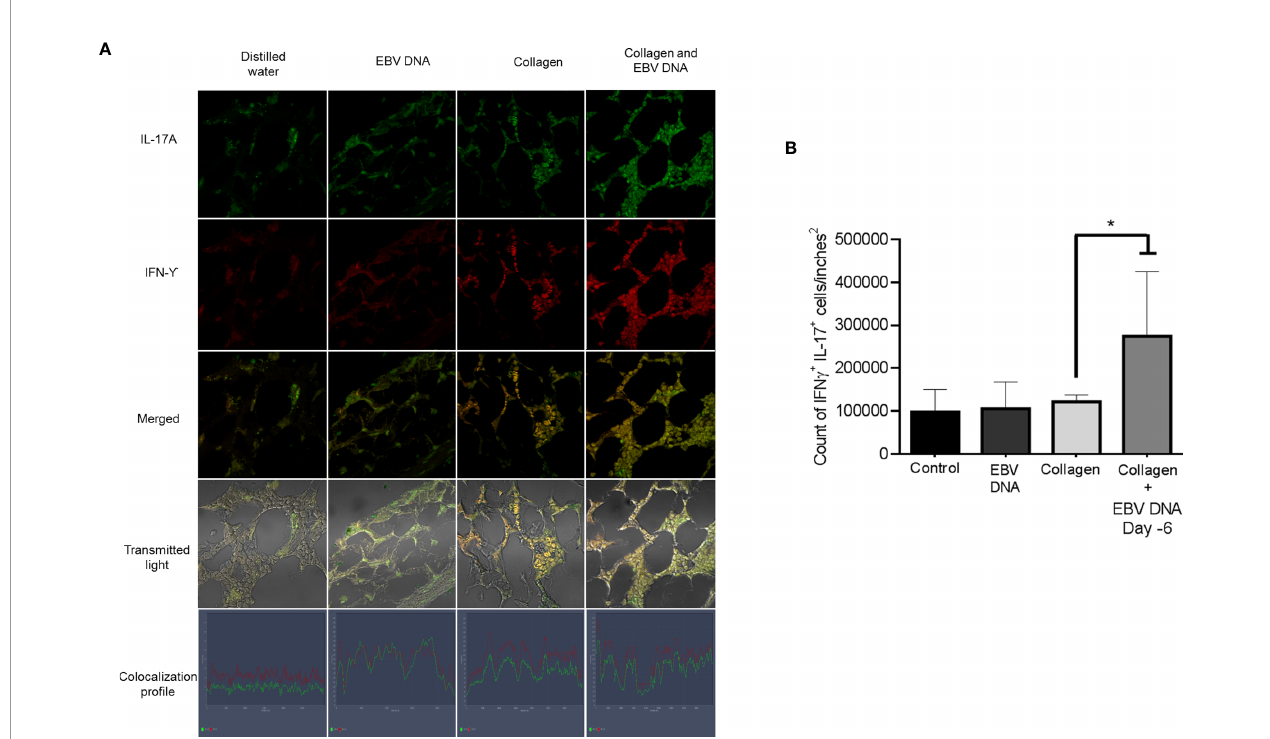
FIGURE 5 | Effect of EBV DNA on IFNY + IL-17 + cells in the collagen-induced arthritis mouse model. (A) Immuno fl uorescent staining for IL-17A and IFNY in ankle joint sections from arthritic animals in C57BL/6J mouse groups treated with EBV DNA, type II chicken collagen, EBV DNA 6 days before collagen or distilled water. (B) IFNY + IL-17 + cell counts in joints of arthritic animals; * indicates p < 0.05 compared to mice treated with collagen